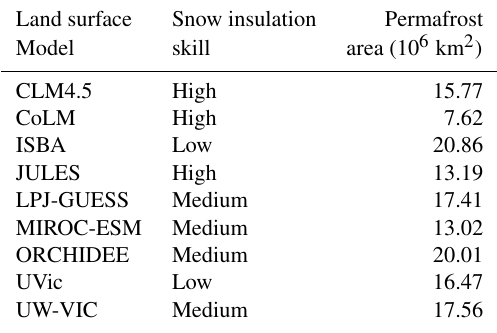
Table 4. Permafrost area, defined as maximum seasonal active layer thickness <3m in 1960 (Mc Guire et al., 2016). The IPA map es- timate is 16millionkm 2 (Brown et al., 1997; Slater and Lawrence,